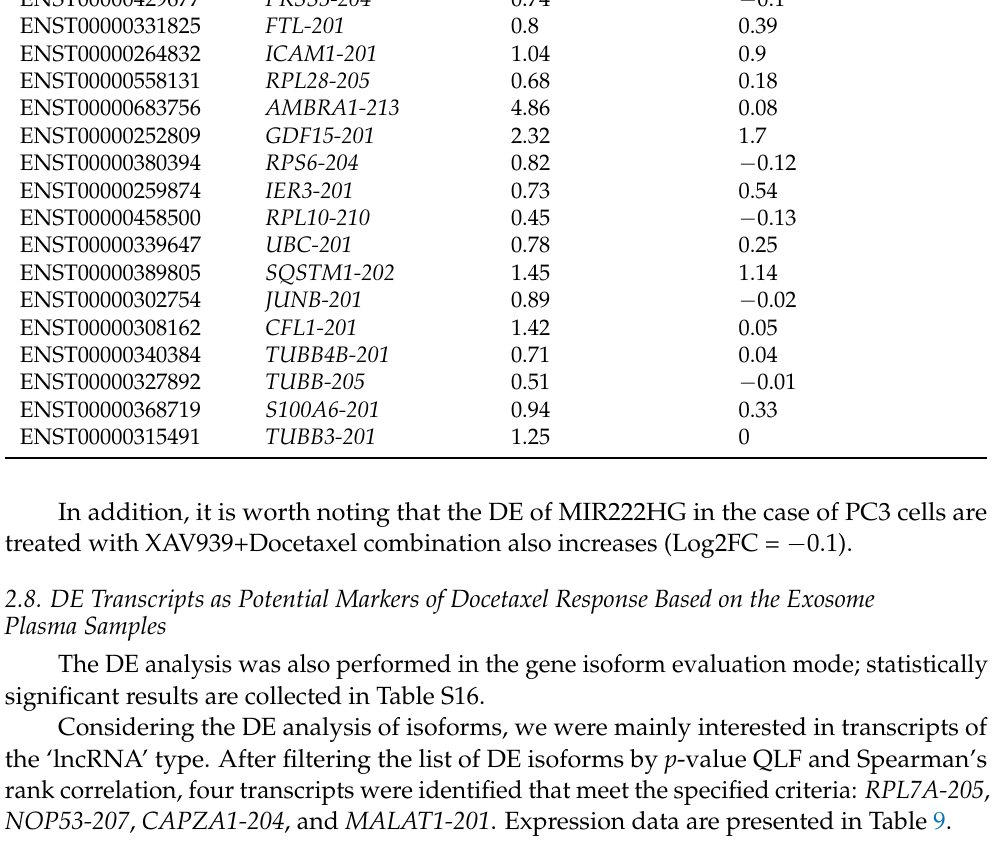
Table 9. List of statistically significant DE transcripts associated with the development of resistance to docetaxel treatment based on plasma exosomes of patients with